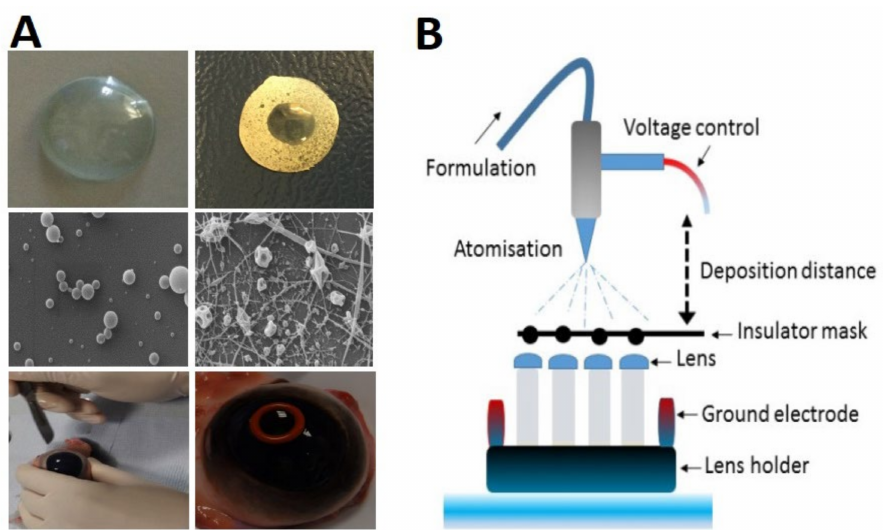
Figure 6. Schematic illustration of ocular lens coating. ( A ) Digital images of an uncoated and densely coated lens; ( B ) EHDA coating process. With permission ©2017, European journal of pharmaceutics and